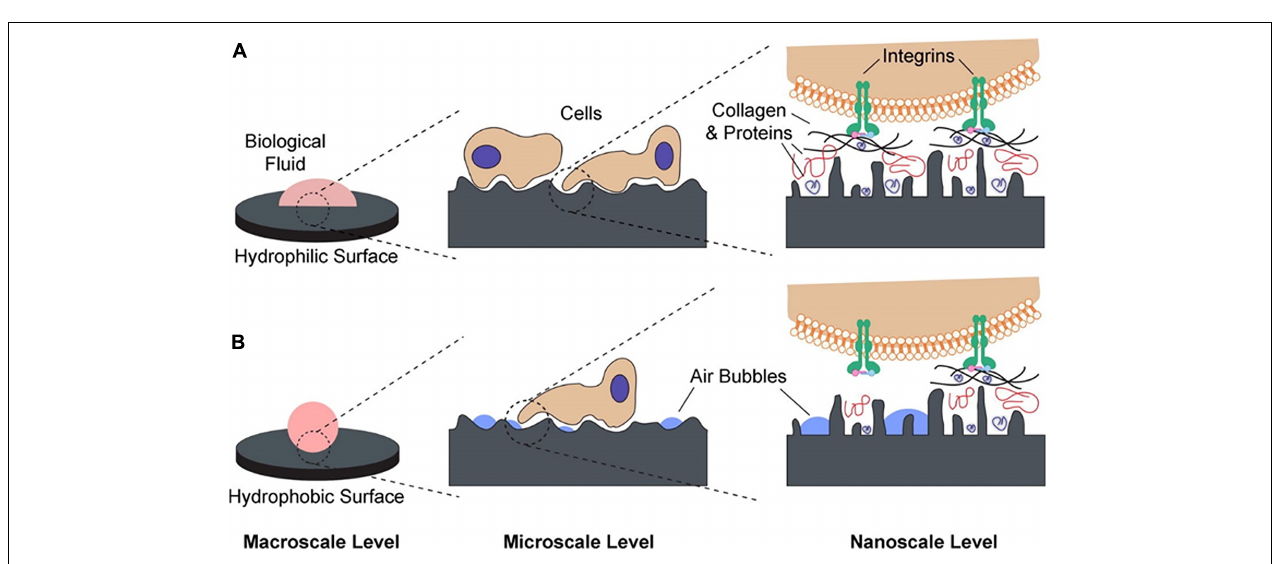
FIGURE 7 | (A) Alizarin red S staining. The media obtained from DPSC on Gp increased the mineralization of cells on Gl (Group 3) after 28 days ( p < 0.05). (B) Alizarin red S staining evinced the presence of calcium-rich deposits in the DPSCs cultured on Gp (28 days) (Xie H, et al., 2017). ∗ Indicates p -value threshold for a statistical significance p < 0.05.